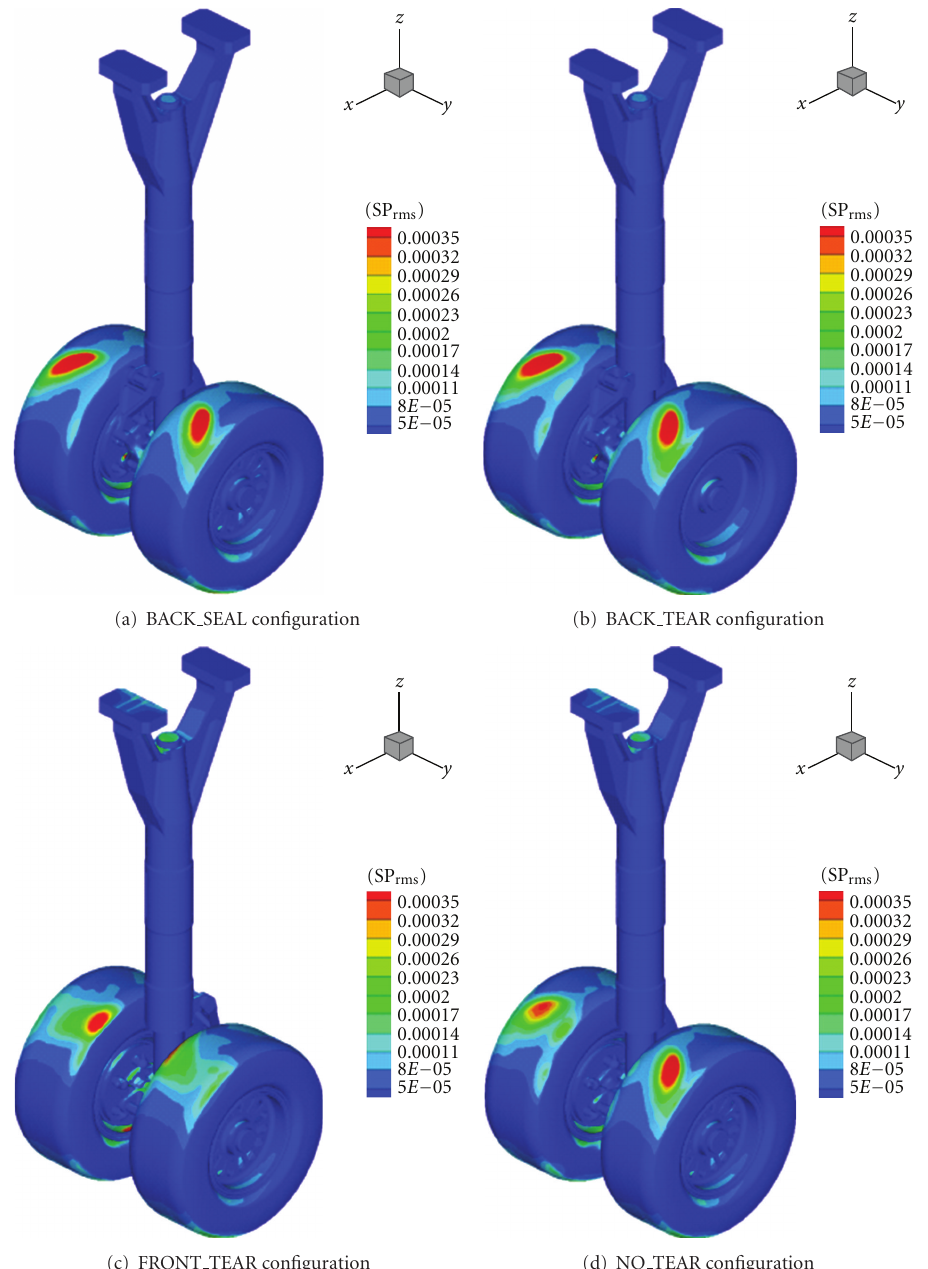
Figure 12: Comparison of surface sound pressure fluctuation of di ff erent LEG configurations (viewed from behind the landing gear).